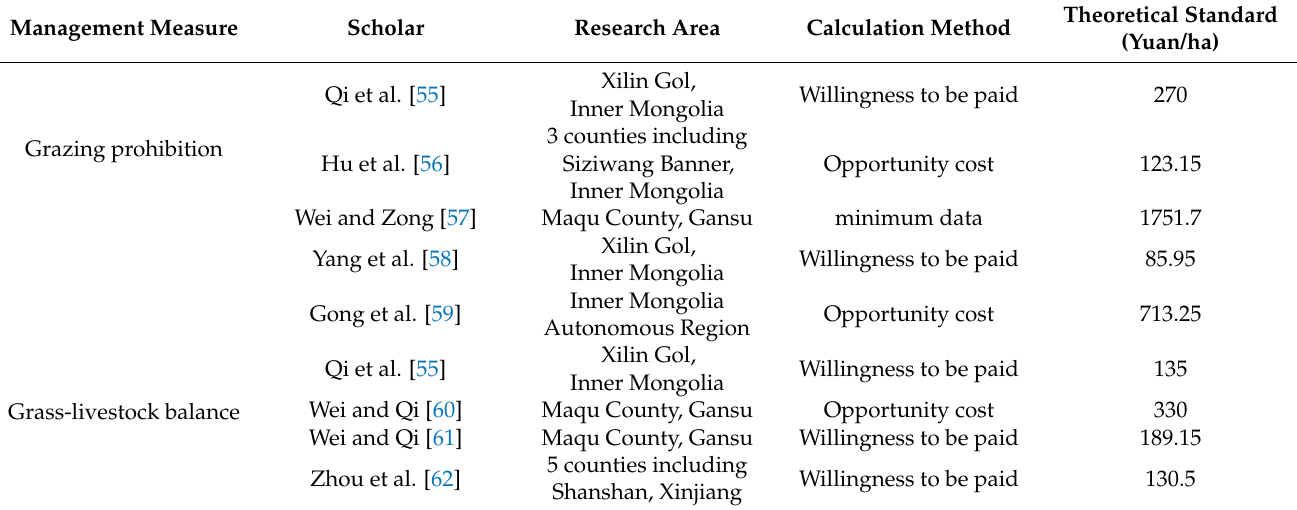
Table 1. Summary table of studies on grassland eco-compensation standards in